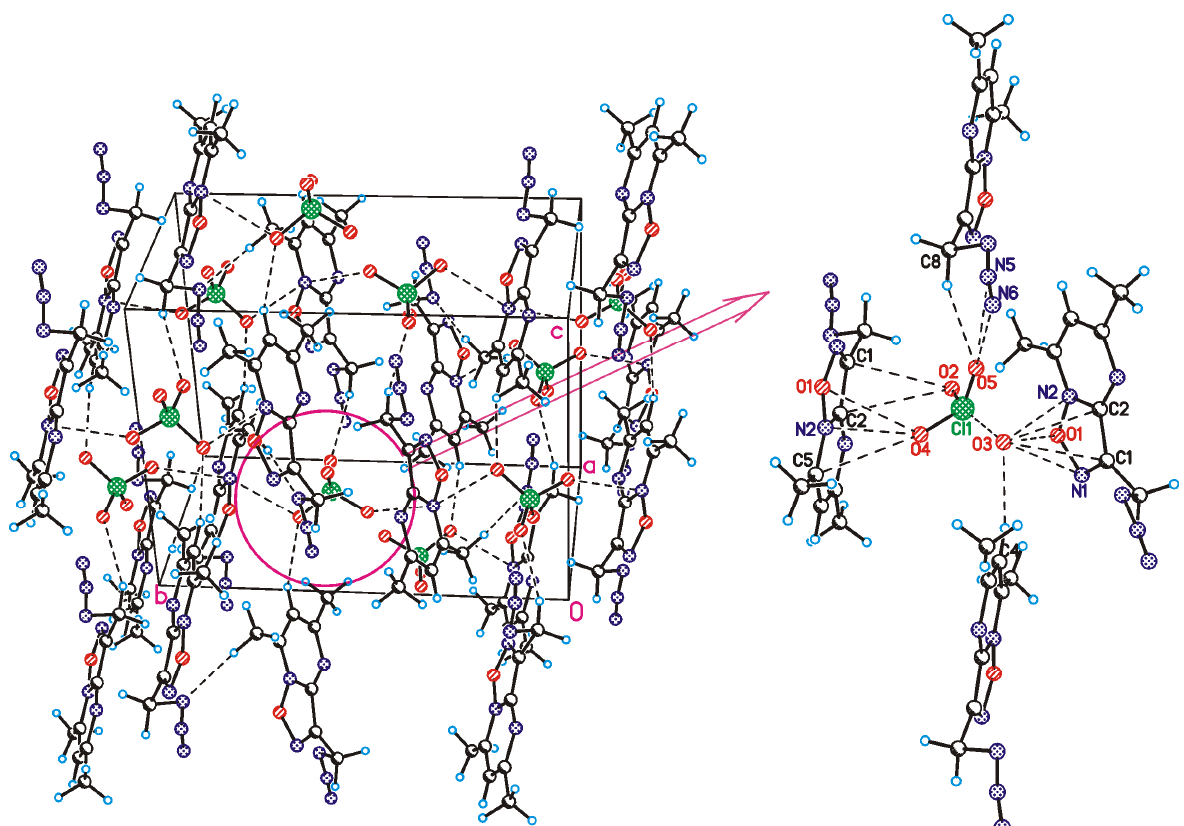
Figure 7. Crystal packing fragment of compound 10f . C – H … N cation … cation and C – H … O and O … π anion … cation interactions are shown by dashed lines. Detailed view of anion – cation interactions is provided on the right side.